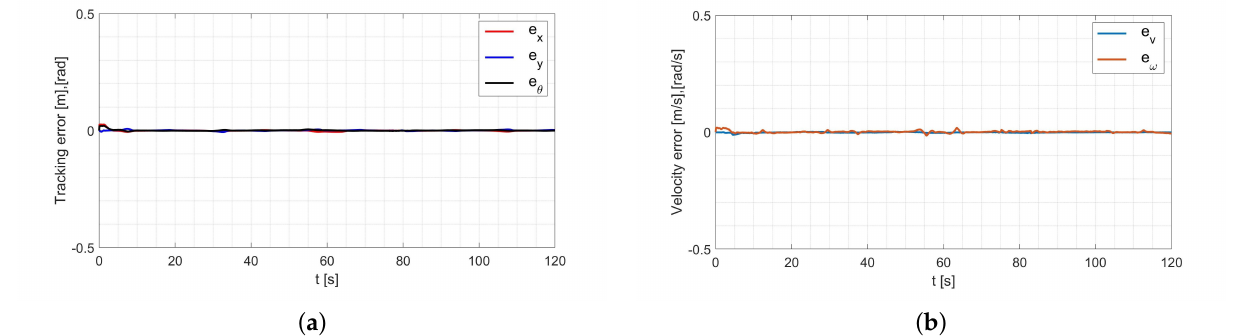
Figure 22. Errors for the RLS method with initial parameters determined by the Levenberg-Marguardt method: ( a ) tracking of the reference trajectory, ( b )